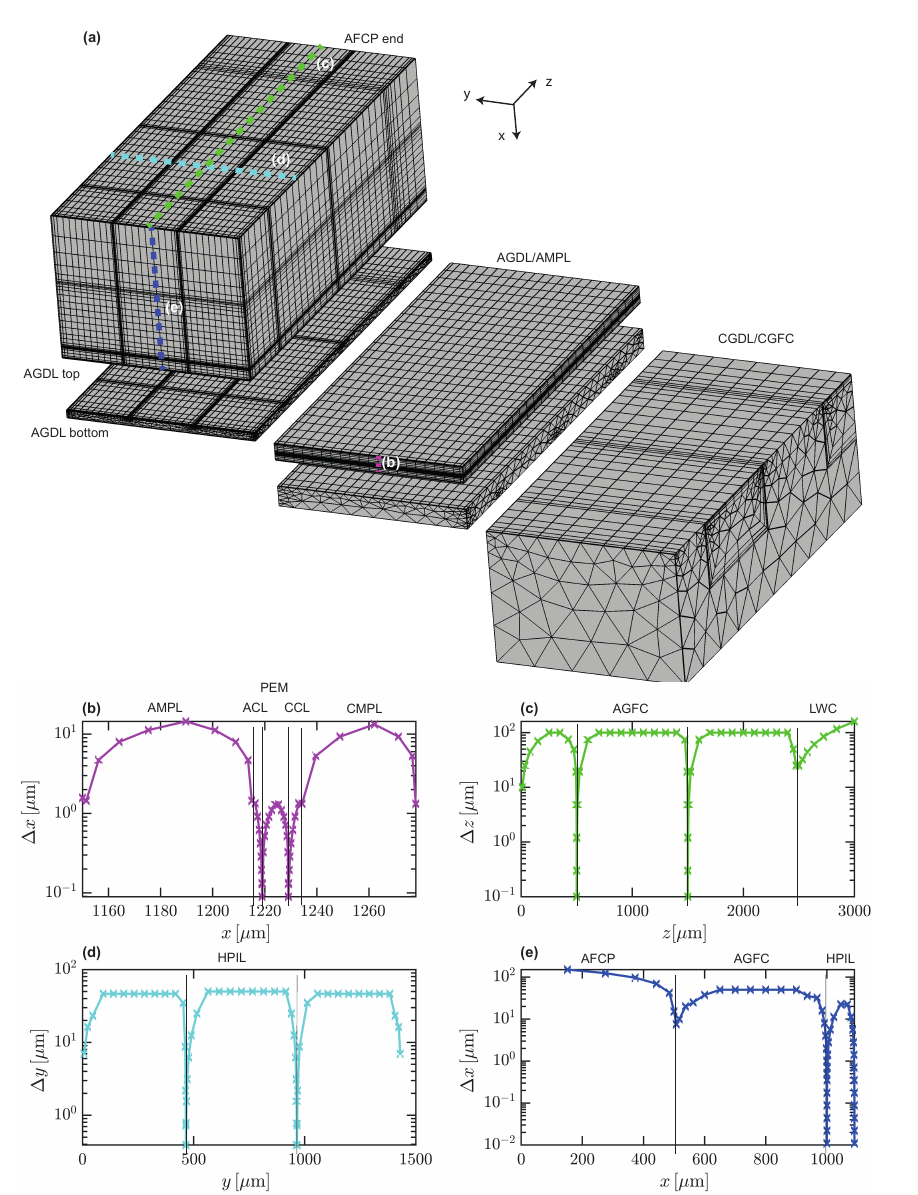
Figure 2. Finite element mesh: ( a ) 3-D plot of the mesh. For visibility, model domains are shifted in space. Finite element sizes ∆ x , ∆ y and ∆ z are shown along different profiles as indicated in ( a ) for the ( b ) profile along the swept mesh of the AGDL/AMPL surface in x-direction, ( c ) profile along the anode FCP surface in z-direction, ( d ) profile along the AFCP surface in y-direction, and ( e ) profile along the swept mesh of the AFCP surface in x-direction until the bottom of the